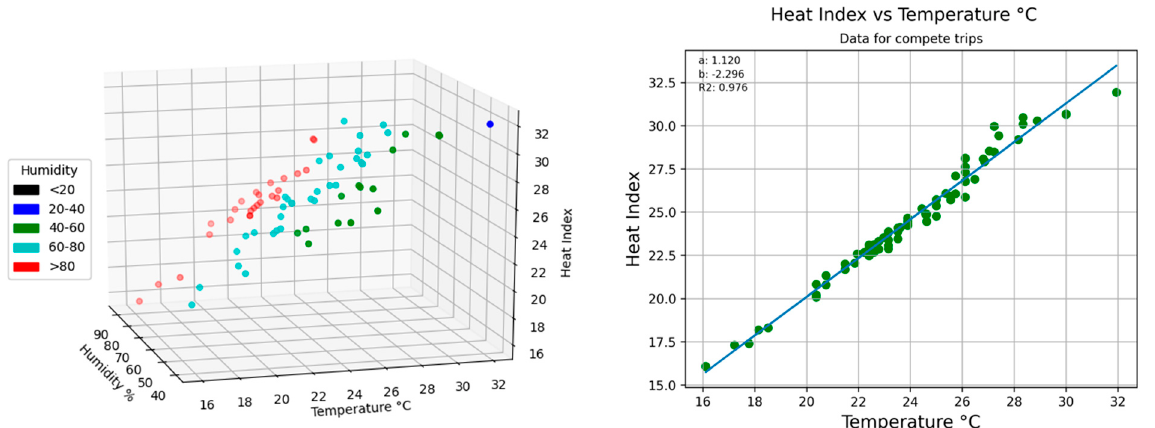
Figure 1. ( Left ) Heat Index as function of 2 m Temperature and Humidity for the data collected during the ENEA campaign in Cagliari, computed following the definition proposed by Anderson et al. [18]. ( Right ) plot of Heat Index in function of only Temperature. Note that the linear coefficient of the interpolation is larger than 1.